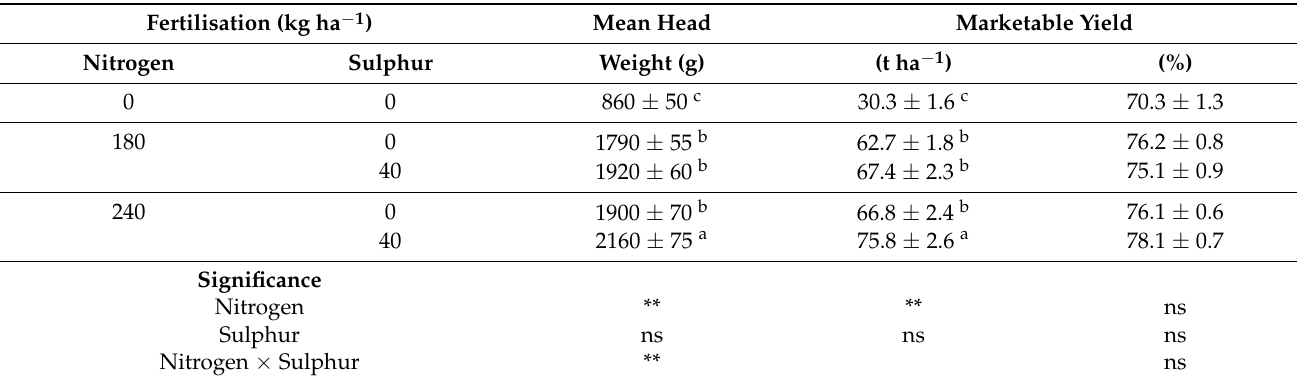
Table 1. Effects of nitrogen and sulphur fertilisation on the marketable yield parameters of white cabbage and the nitrogen and sulphur interactions.